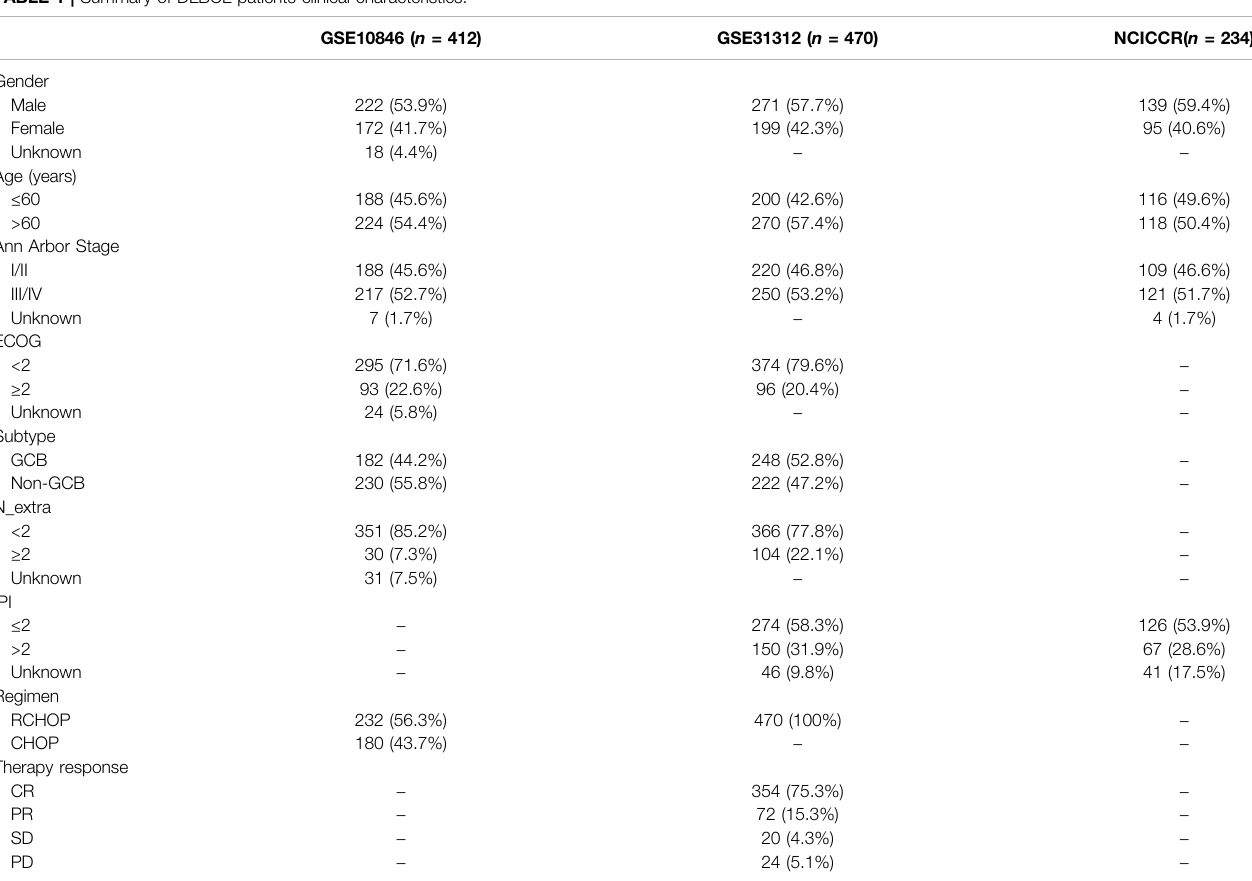
TABLE 1 | Summary of DLBCL patients clinical